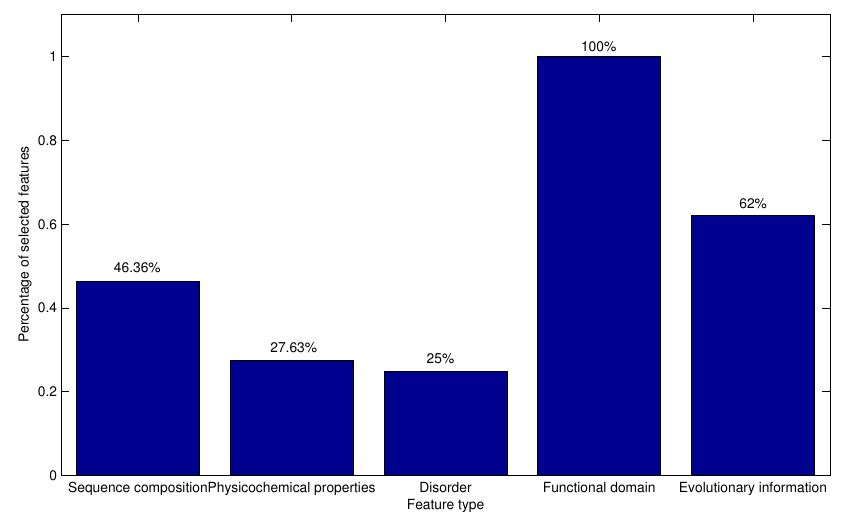
Figure 5. The percentage of the selected features accounting for the corresponding feature type. The five types of features are derived from sequence composition, physicochemical properties, disorder, functional domain and evolutionary information, respectively.